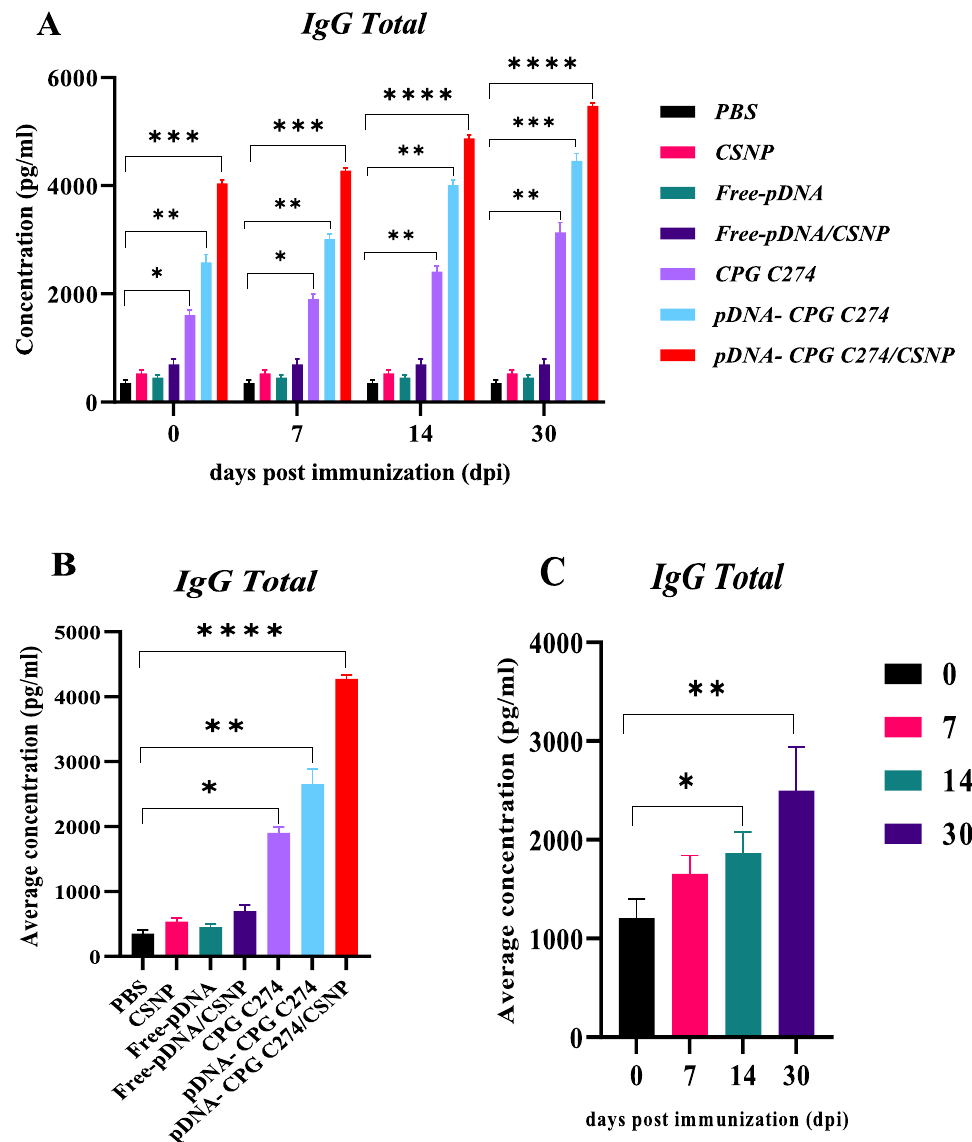
Fig. 4 Humoral immune responses to plasmids containing CpG ODNs and other groups in mouse. A Total IgG in different groups on 0, 7, 14 and 30 dpi. B Average concentration (pg/ml) of Total IgG in different groups. C Average concentration (pg/ml) of Total IgG on 0, 7, 14 and 30 dpi. Data in the plot present the mean SEM, n 10 (ns, nonsignificant, *p 0.05; **p 0.01, ***p 0.001, ****p ± = ≤ ≤ ≤ ≤